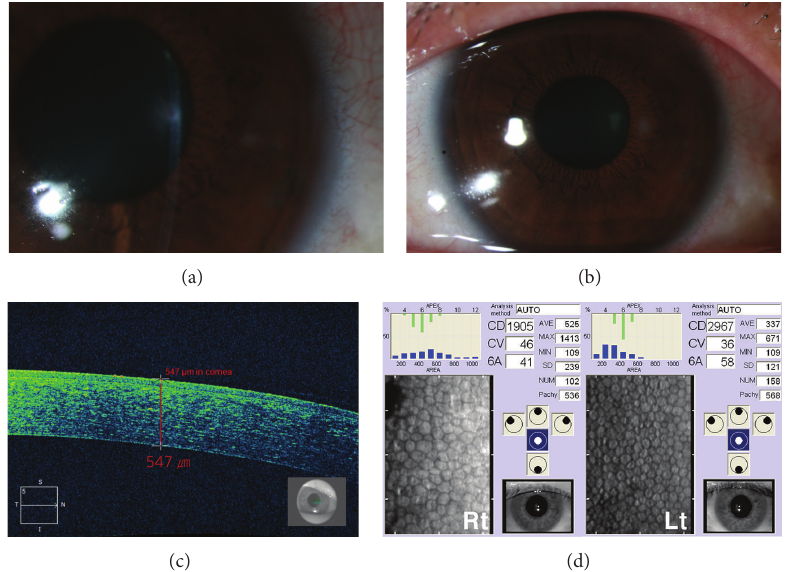
Figure 2: (a) Anterior segment photography showing resolution of corneal edema with small opacity around the site of bee sting. (b) Anterior segment photography showing the restoration of corneal clarity except small opacity around the site of injury. (c) Anterior segment optical coherence tomography demonstrating complete resolution of corneal swelling and normal corneal thickness (547 𝜇 m). (d) Specular microscopy revealing no additional loss in endothelial cell density in the right eye, although decreased endothelial cell density in the right